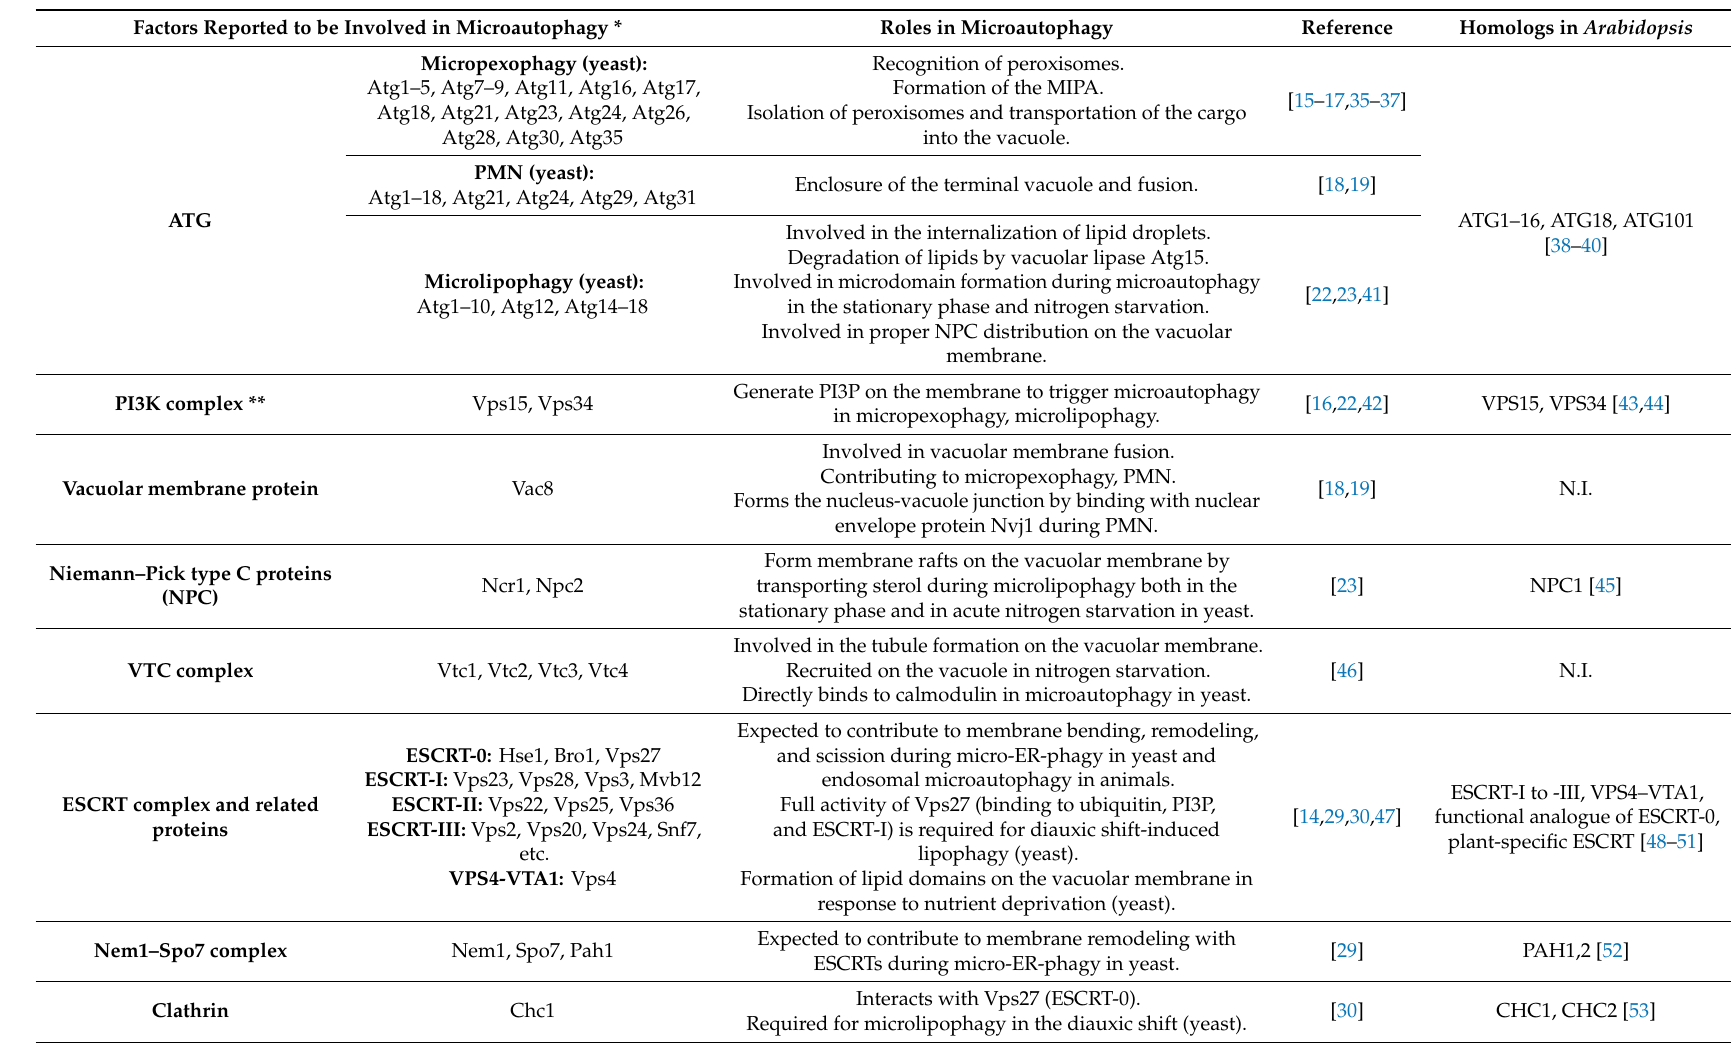
Table 1. Microautophagy-related factors and their homologs in Arabidopsis